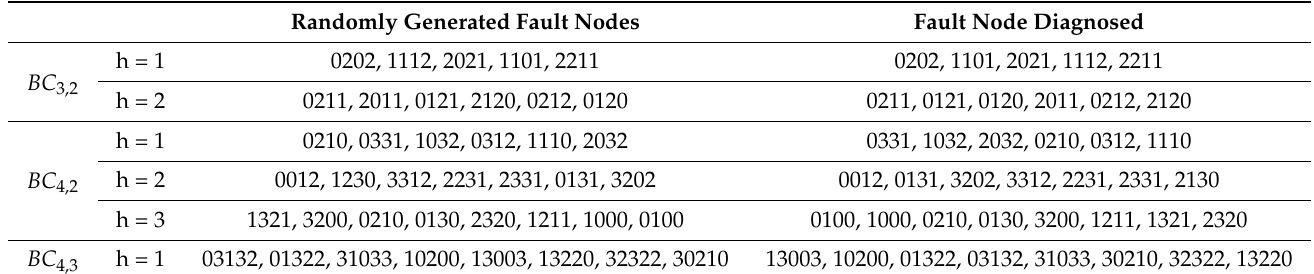
Table 2. The experimental results obtained by executing the t/h-diag algorithm. Randomly Generated Fault Nodes Fault Node